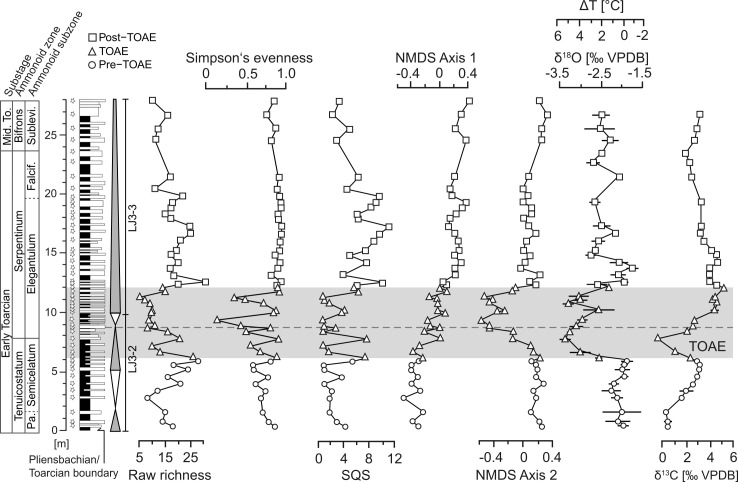
Stratigraphy, transgressive-regressive cycles, geochemistry, and paleoecology at Barranco de la Cañada.Biodiversity metrics (richness, evenness, and Shareholder Quorum Subsampling [SQS] diversity) are based on the taxonomic composition of faunal samples. Non-metric multidimensional scaling (NMDS) curves represent the values of axis 1 and axis 2 of the NMDS ordination of Fig 5A. SQS-diversity calculated after Alroy [56]. Third order transgressive-regressive cycles from refs. [15,53]. Isotope data from ref. [57]; the temperature change ΔT was calculated relative to the lowermost value recorded in the section using Brand’s equation [58], following refs. [45,57]. Horizontal bars in the isotope time series represent the double standard error for each sample. For additional information, see caption of Fig 2.